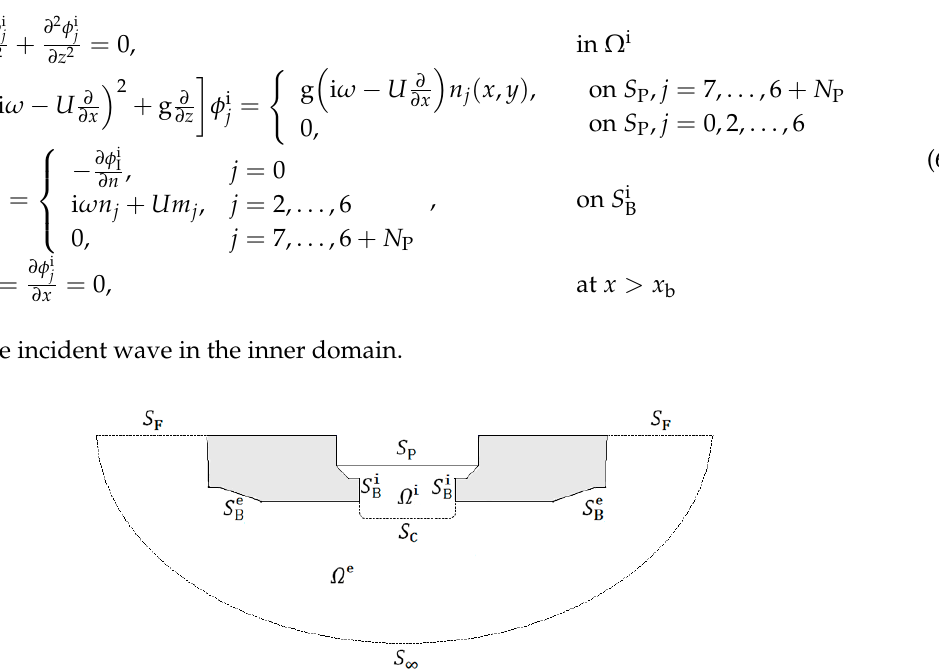
, splitter S C , and B , and B